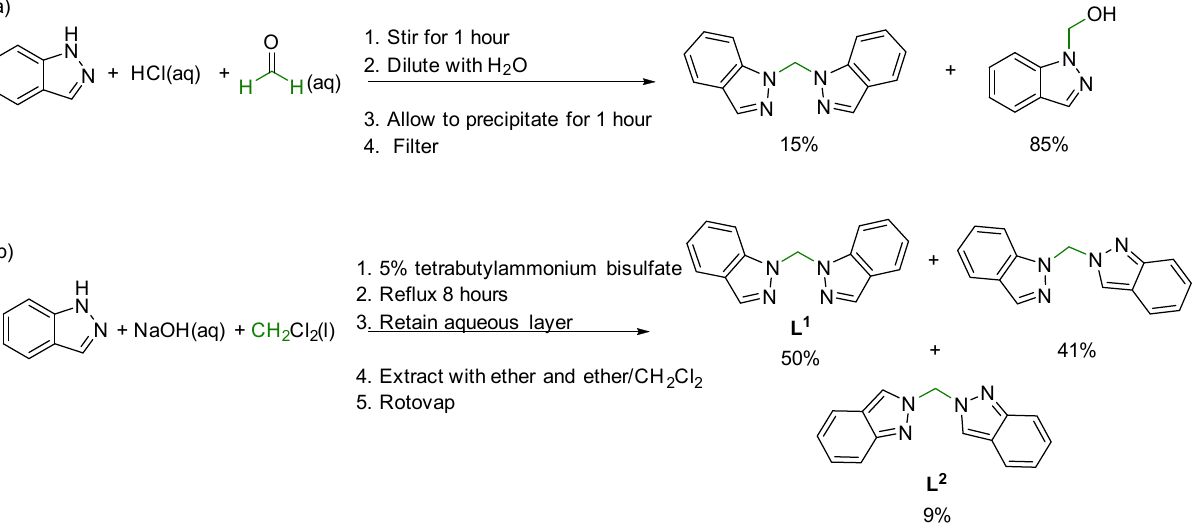
Figure 1. Substitution positions and structural similarities for neutral ( a ) bis(1 H -pyrazol-1-yl)methane and ( b ) bis(1 H -indazol-1-yl)methane chelating ligands shown arranged for bidentate binding through the two nitrogen atoms colored in blue. Upon bidentate binding to a metal center, these ligands form six-membered rings with boat conformations.